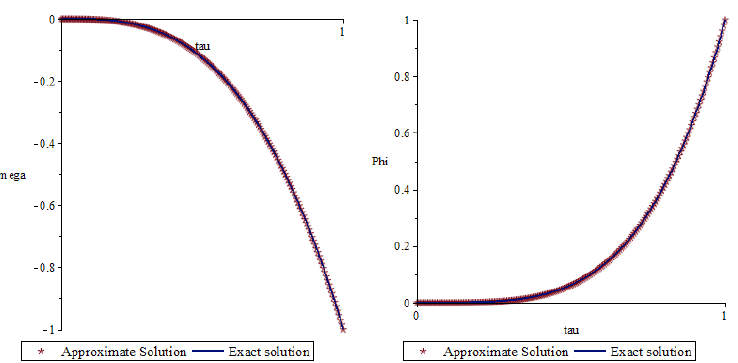
Figure 2. Comparison of exact solutions Ω and φ and approximate solutions Ω n and φ n , respectively, for the second example, where n =